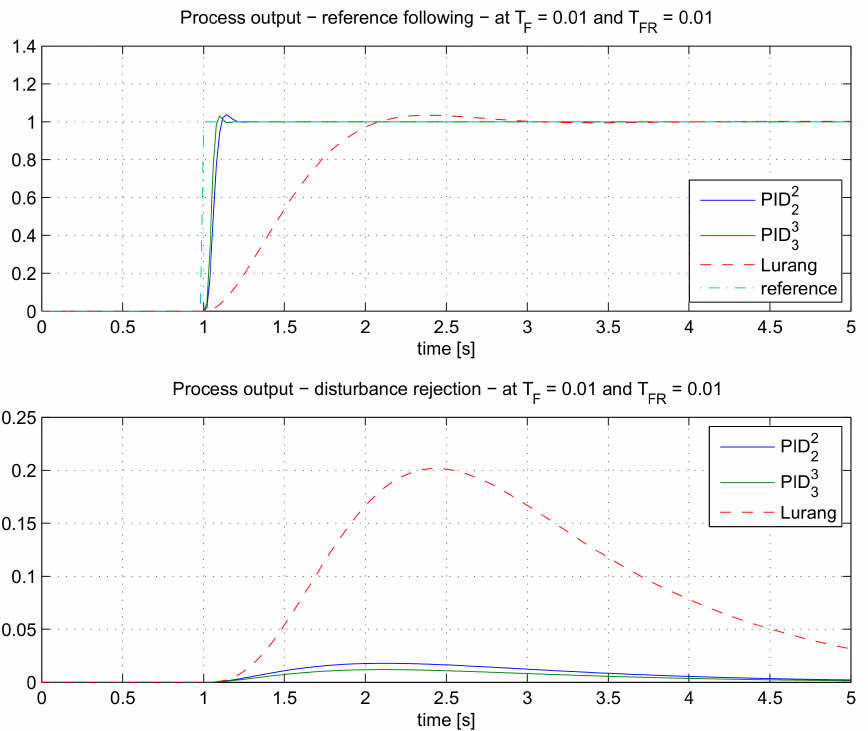
Figure 13. The comparison of the closed-loop responses for the process G P 5 ( s ) when using PID 2 PID 3 and the Lurang 3